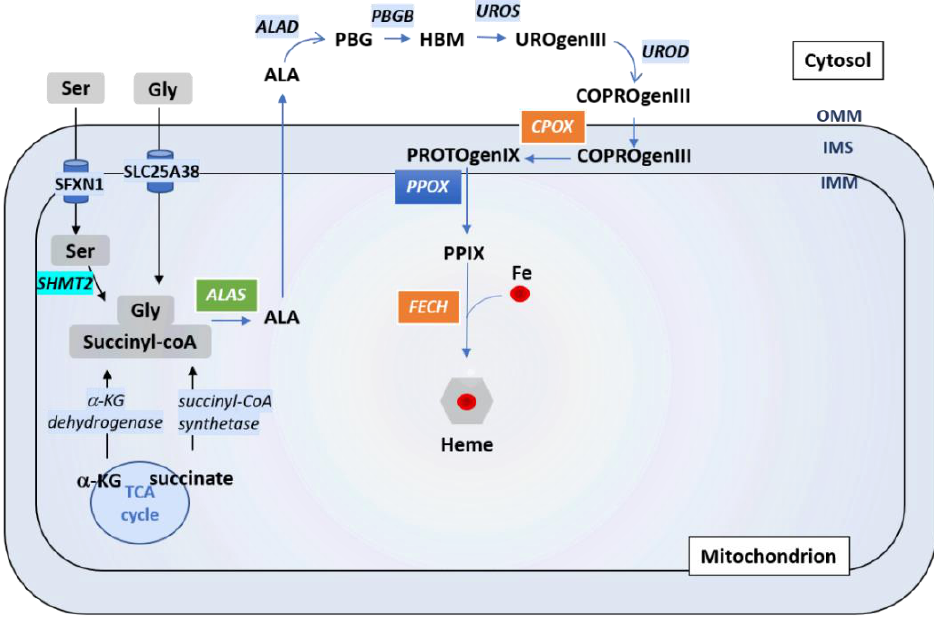
Figure 6. Regulation of heme biosynthesis by SFXN1. Gly and succinyl CoA are the substrates to generate ALA, the first heme precursor, thanks to ALAS enzyme. Gly can enter directly into the mitochondria by SLC25A38, or can be the result of Ser transformation (previously imported by SFXN1) by SHMT2. ALA is further exported to the cytosol where the next steps of heme biosynthesis are catalysed by ALAD, PBGB, UROS and UROD. CPOX, PPOX and FECH are the three mitochondrial enzymes that catalyze the three last steps of heme synthesis (see main text). The last step corresponds to the incorporation of iron into the protoporphyrin PPIX to complete the heme synthesis. Cells lacking SFXN1 show decreased CPOX and FECH mRNA and protein levels (orange box), but a higher amount of ALAS protein (green box), according to Acoba et al. [16] .